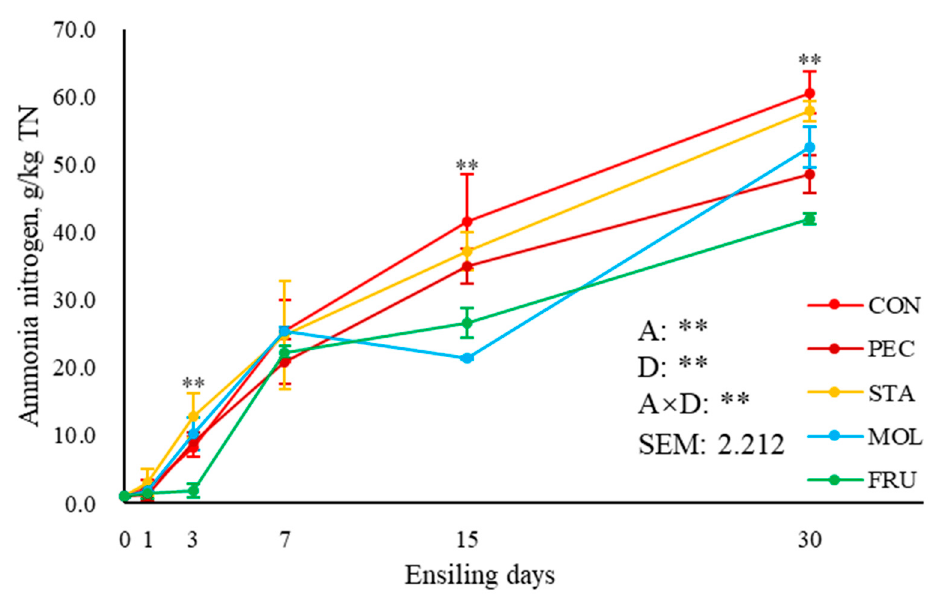
Figure 2. Effect of additives on the ammonia nitrogen (AN) content during ensiling of alfalfa. TN, total nitrogen; CON, control; PEC, pectin; STA, starch; MOL, molasses; FRU, fructose. A denotes significance of additives; D, denotes significance of ensiling days; A × D denotes the interactive effect between additives and ensiling days. SEM, standard error of means. The asterisks (** p ≤ 0.01) indicate the significance of additives and ensiling days and their interaction effects, and the difference at the specified ensiling day.